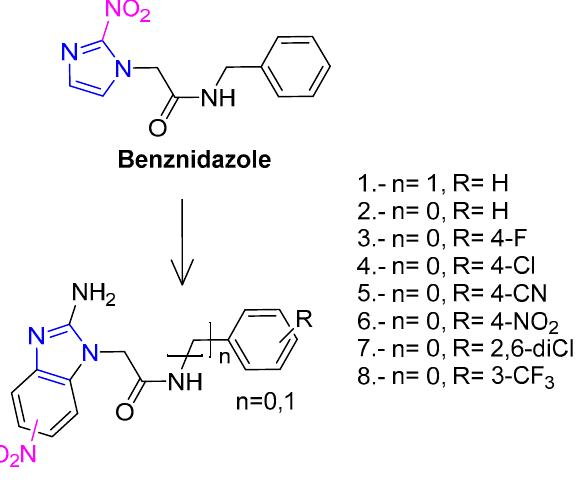
Scheme 1. Drug design of benznidazole analogues.